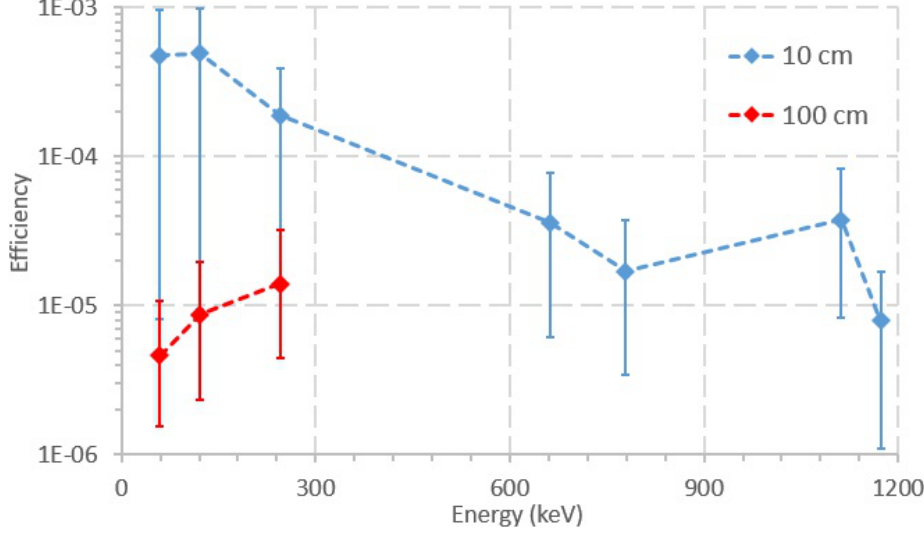
Figure 7. Efficiency of the photopeaks acquired at 10 and 100 cm. The acquisition time was 1800 s.